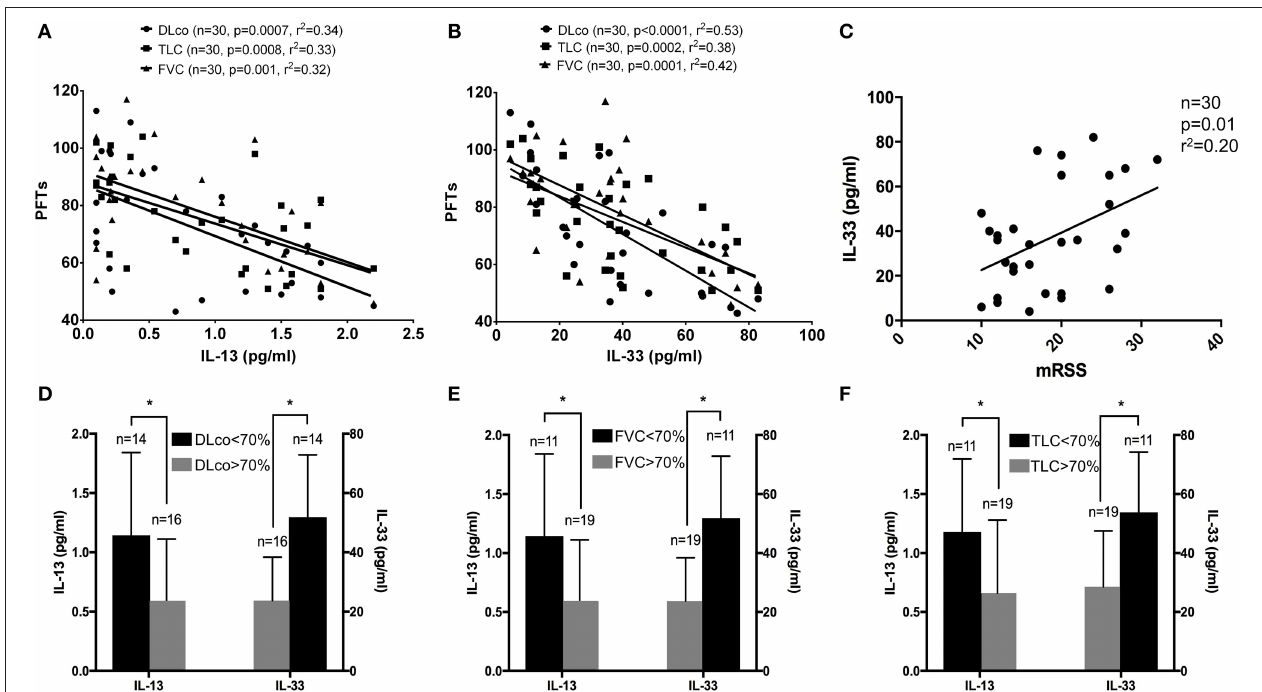
FIGURE 1 | (A–F) Linear regression results for IL-13 and IL-33 and pulmonary function tests: both IL-13 and IL-33 levels were significantly associated with DLco (circle), TLC (square) and FVC (triangle) in systemic sclerosis (SSc) patients (A,B) . A significant direct association was observed between IL-33 levels and modified Rodnan skin score in the entire cohort of SSc patients (C) . IL-13 and IL-33 were plotted, respectively, on the left and right ordinate of each image to show the difference in concentrations according to the 70% cut-off for DLco (D) , FVC (E) and TLC (F) for SSc patients. * p < 0.05.